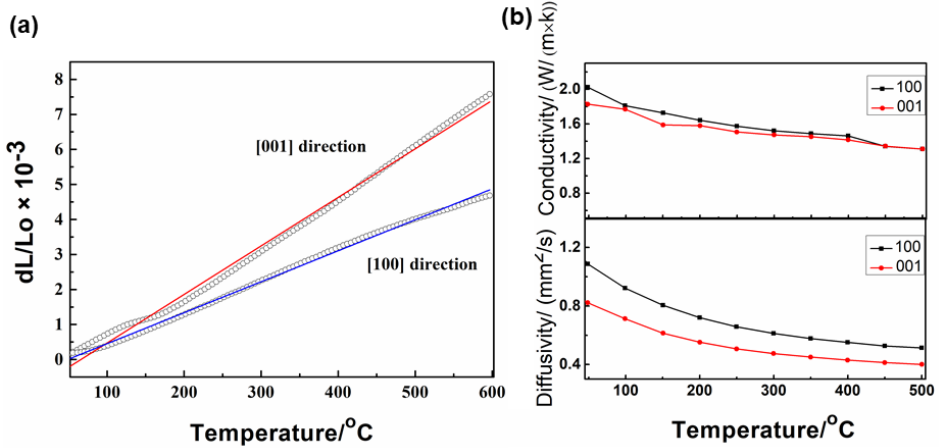
Figure 7. ( a ) Thermal expansion curves, ( b ) thermal conductivity curves, and ( c ) thermal diffusivity curves of KBOB crystal along the different crystallographic axis.